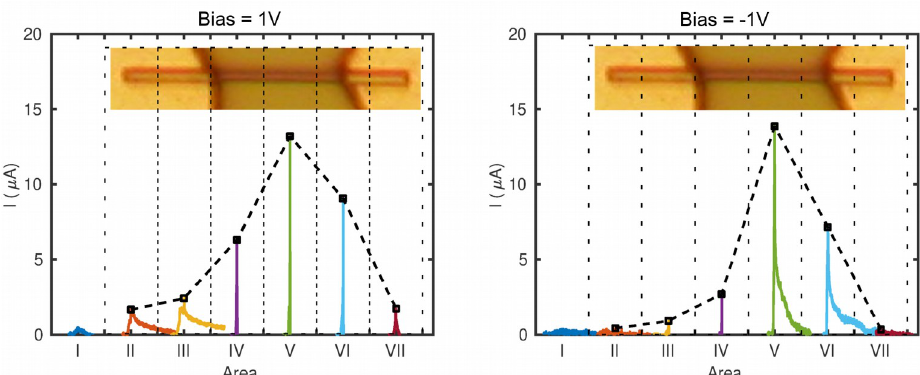
Fig. 3. Ion beam induced current measurement when irradiating the different areas of the microwire, at a bias of 1 V (left) and at a bias of -1 V (right). The dashed lines indicate which area corresponds to each peak. For both positive and negative bias it is clear that the highest IBIC is measured when irradiating area V. Note that for each measurement the background current was